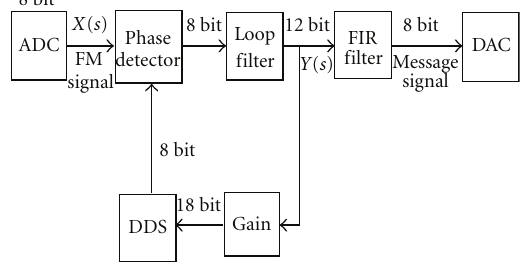
Figure 7: Block diagram of digital FM demodulator circuit.